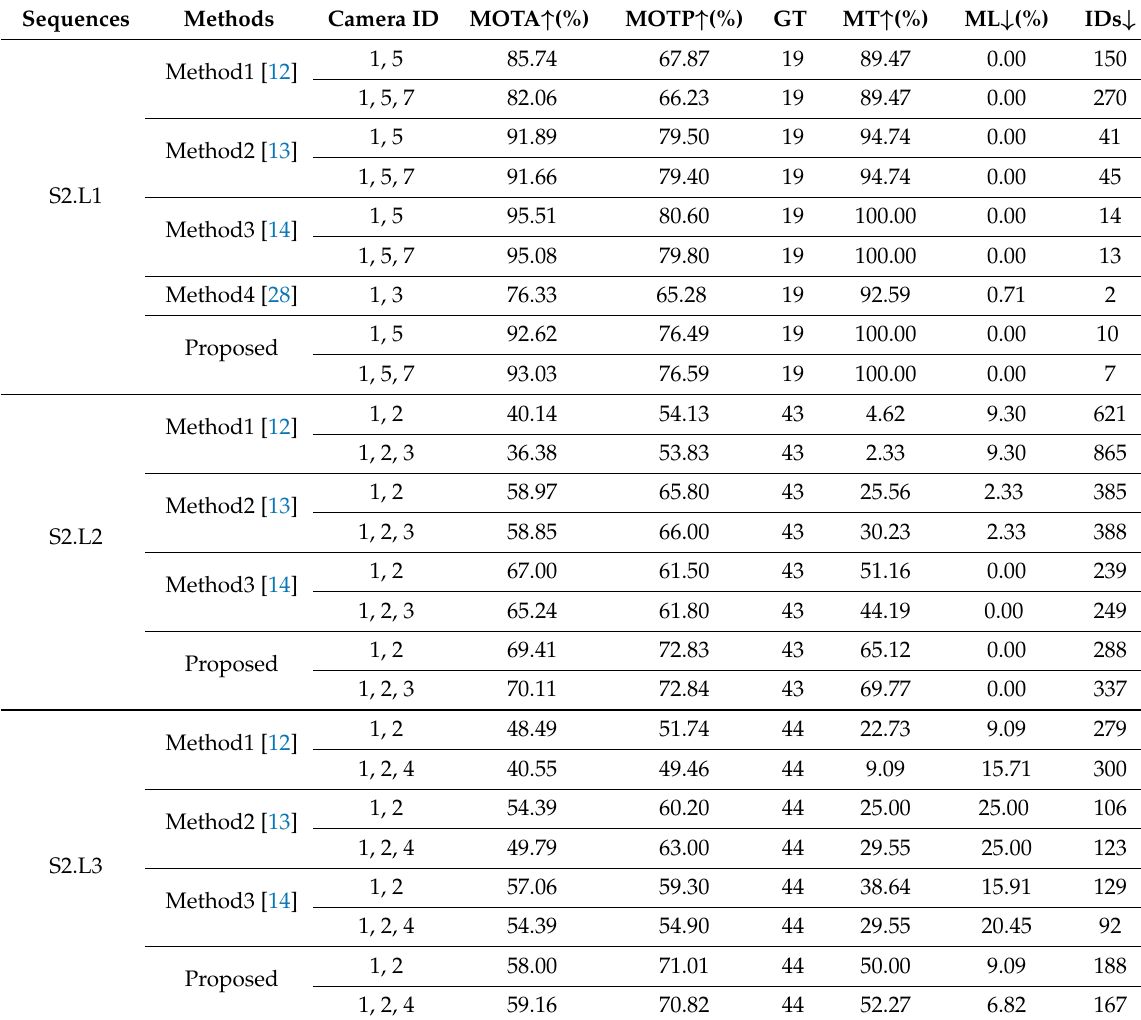
Table 2. Comparisons of tracking